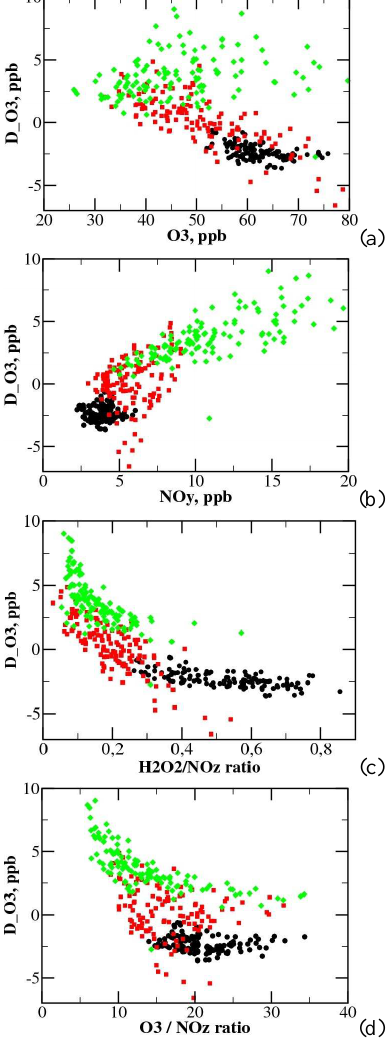
Fig. 7. Scatter plots of chemical regime at 15:00UT [ppb] for all days in summer 2001 versus regime indicators : (a) 15:00UT ozone [ppb], (b) 15:00UT NO y [ppb], (c) 15:00UT H 2 O 2 /NO z ra- tio, (c) 15:00UT O 3 / NO z ratio. Black circles indicate averages for the Mediterranean area (6 ◦ W–20 ◦ E, 38 ◦ N–43 ◦ N), red squares for North-Eastern Germany (9 ◦ E–14 ◦ E, 50 ◦ N–54 ◦ N), green dia- monds for North-Western Europe (1 ◦ W–6 ◦ E, 50 ◦ N–53 ◦ N). Fig- ure 1d shows the locations of the three